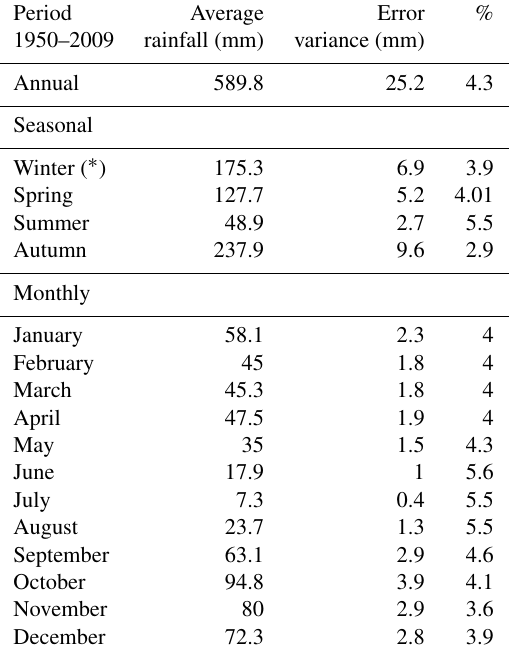
Table 1. Mean annual, seasonal and monthly accumulations spa- tially averaged across the Balearic